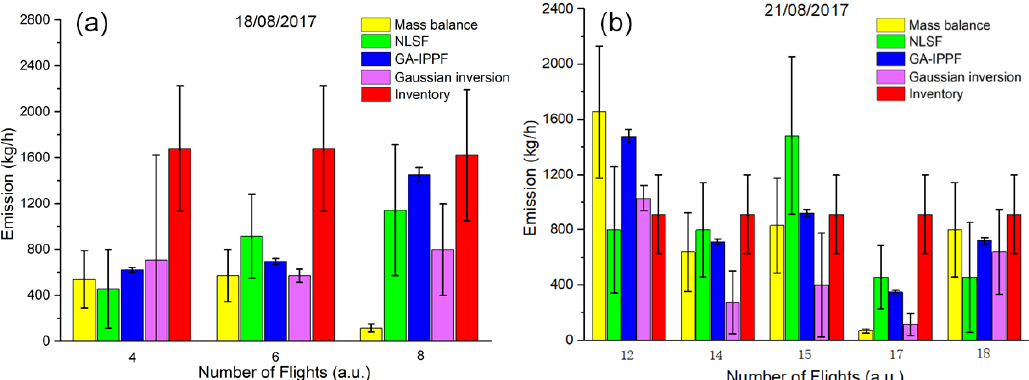
Figure 5. Quantified CH 4 emission by different methods based on the collected data: (a) 18 August 2017 and (b) 21 August 2017. CH 4 - emission rates from ventilation shafts calculated by mass balance and inverse Gaussian refer to Andersen et al. (2021).